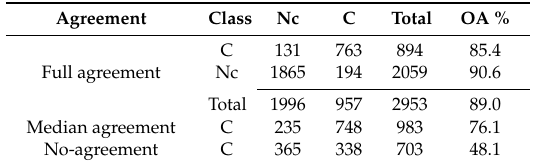
Table 5. Assessing the accuracy of mapping cropland in the three agreement levels among land cover (LC)